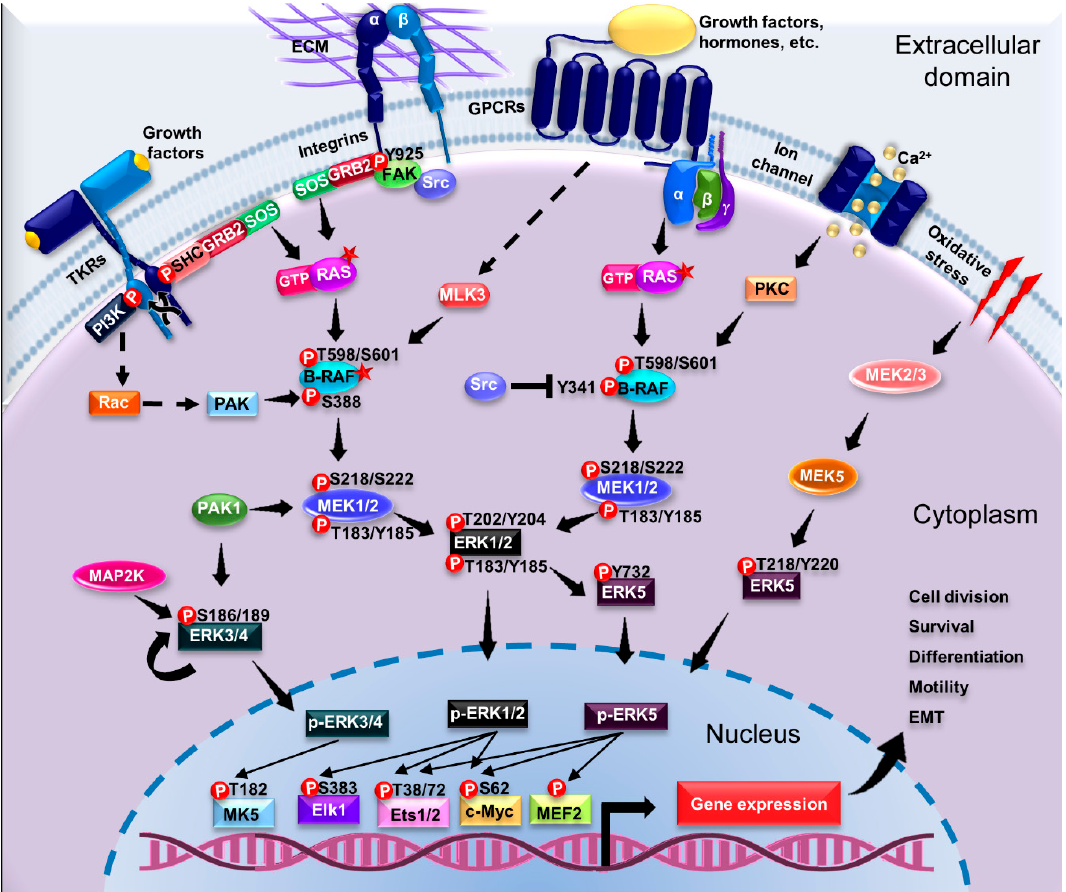
Figure 3. Signaling pathways driving ERK activation, effectors, and cellular processes regulated by this kinase.